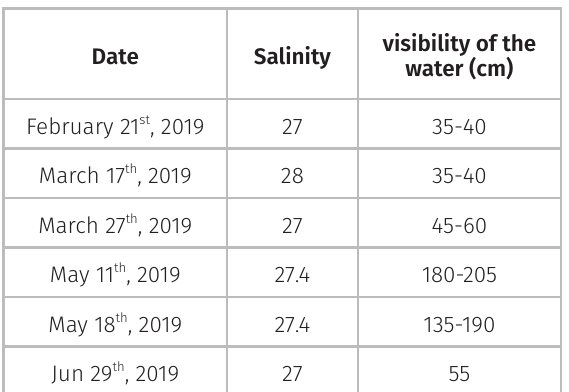
Table II. Recorded salinity and transparency of the water (Puerto Velero).